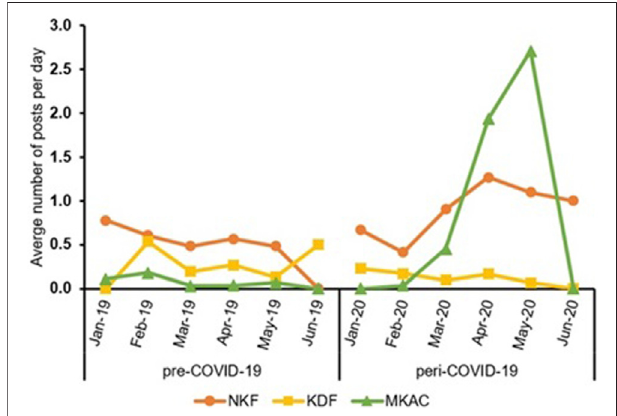
FIGURE2| AveragenumberofpostsperdaybythethreeSSAsforeach month during pre-COVID-19 and peri- COVID-19 periods.